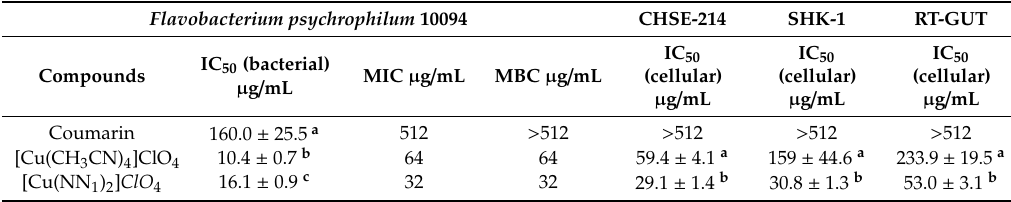
Table 1. Comparative table of MIC, MBC and IC 50 on F. psychrophilum ( n = 3) at 72 h post-incubation and IC 50 on Chinook salmon embryo (CHSE-214), Salmon Head Kidney-1 (SHK-1) and intestinal